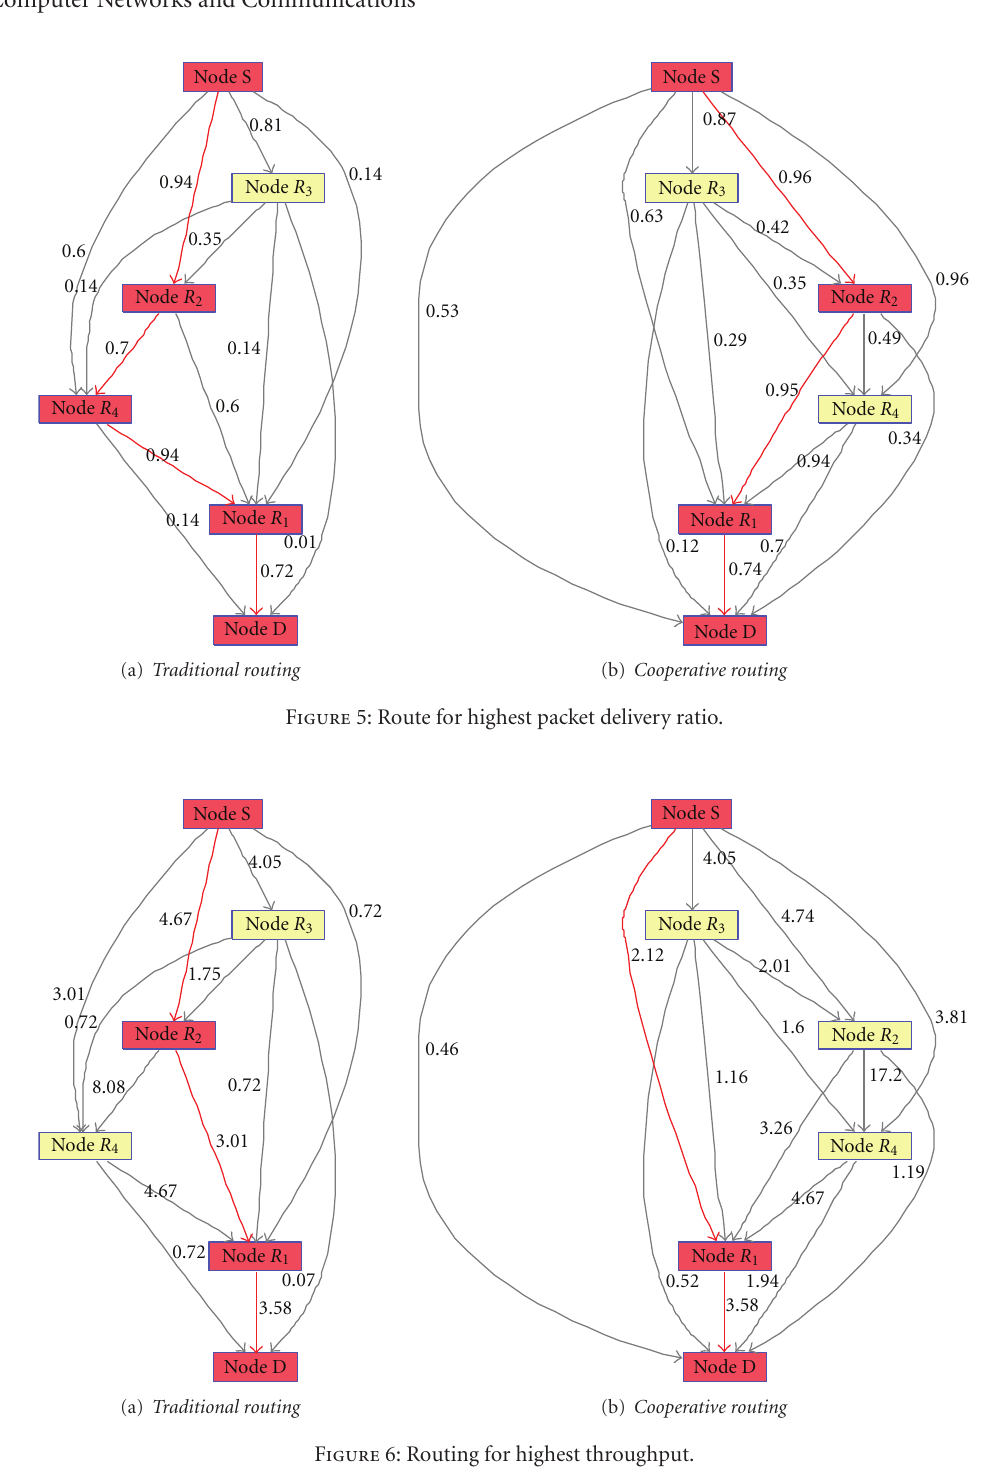
Figure 6: Routing for highest